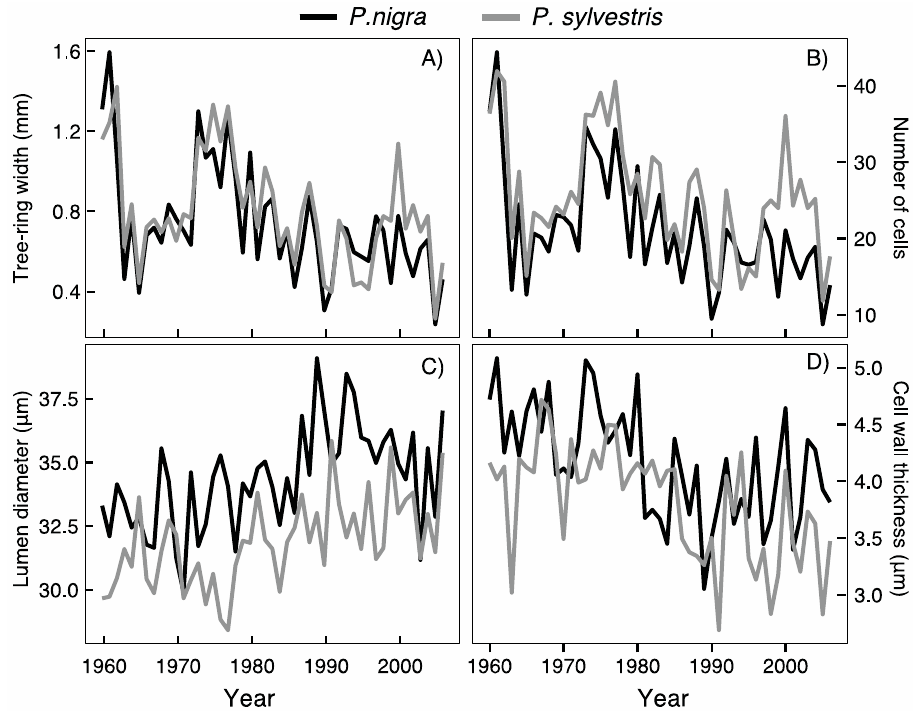
Figure 2. Mean species chronologies for different tree-ring traits and correlation coefficients between species. ( A ) Tree-ring width ( r = 0.85, p = <0.001); ( B ) number of cells, ( r = 0.86, p =< 0.001); ( C ) tracheid lumen diameter, ( r = 0.42, p = 0.004); and ( D ) cell wall thickness ( r = 0.46, p = 0.001). Note different scales in the y-axis of the four panels.